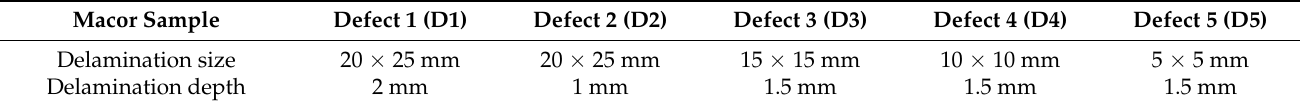
Figure 5. The sample under test with the delamination’s size and location. Table 3. Actual delamination size and depth in fabricated Macor